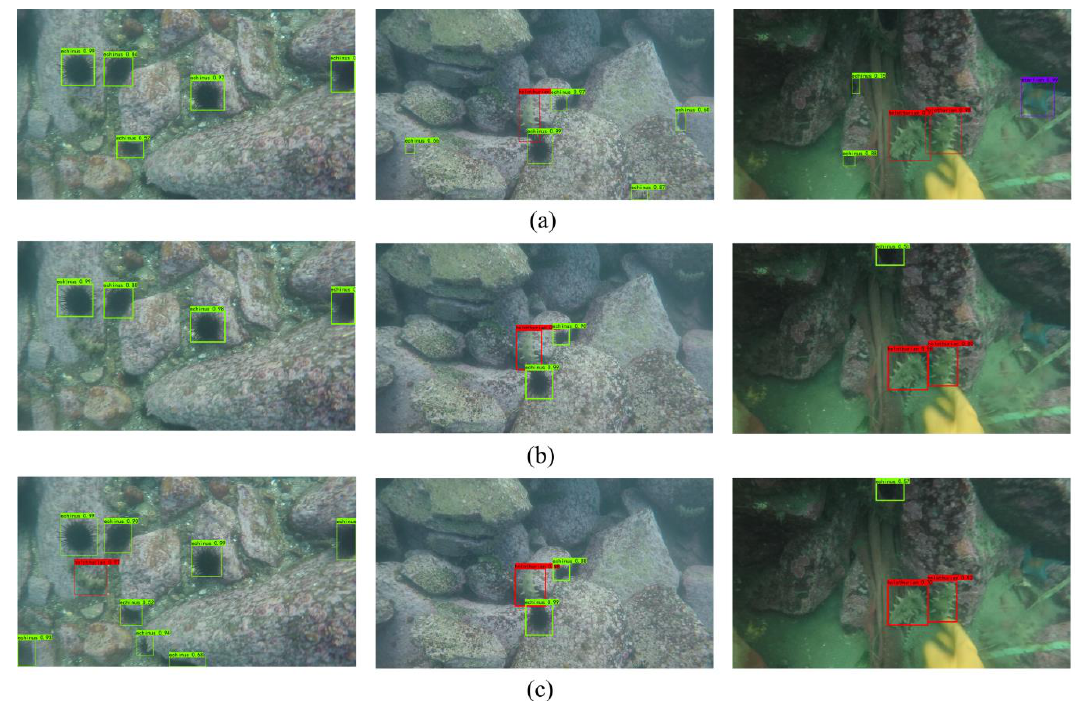
Figure 10. Detection results of different detection algorithms on the URPC dataset. ( a ) Faster-RCNN test results, ( b ) YOLOV3-Tiny test results, and ( c ) YOLOV4-Tinier test results.